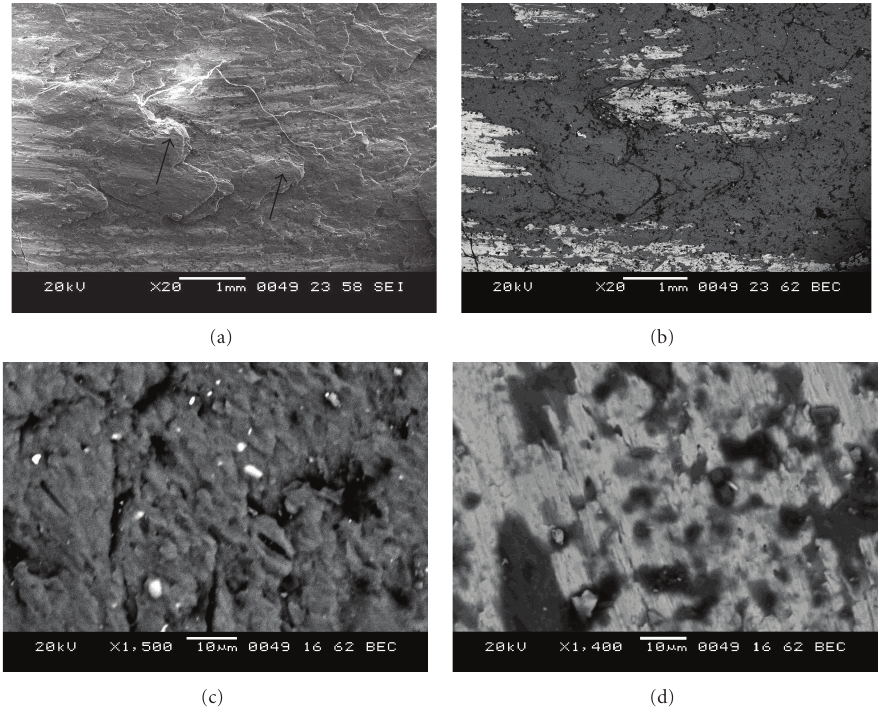
Figure 3: (a) A low-magnification micrograph of friction-surfaced region. (b) SEM: backscattered electron-compositional (BEC) image. (c) and (d) are micrographs taken from Fe-rich and Al-rich regions of Figure (b). In Figure (c) Al-rich region with fine Fe particles is observed. In (d) Fe-rich region has embedded small Al